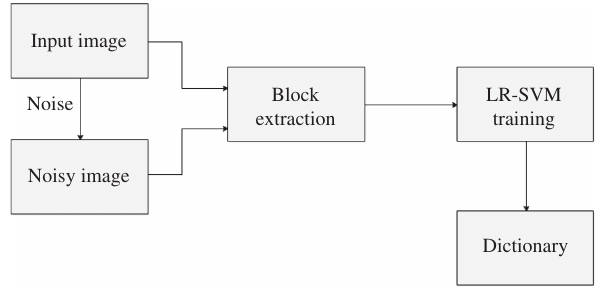
Figure 1: Block Diagram for LR-SVM